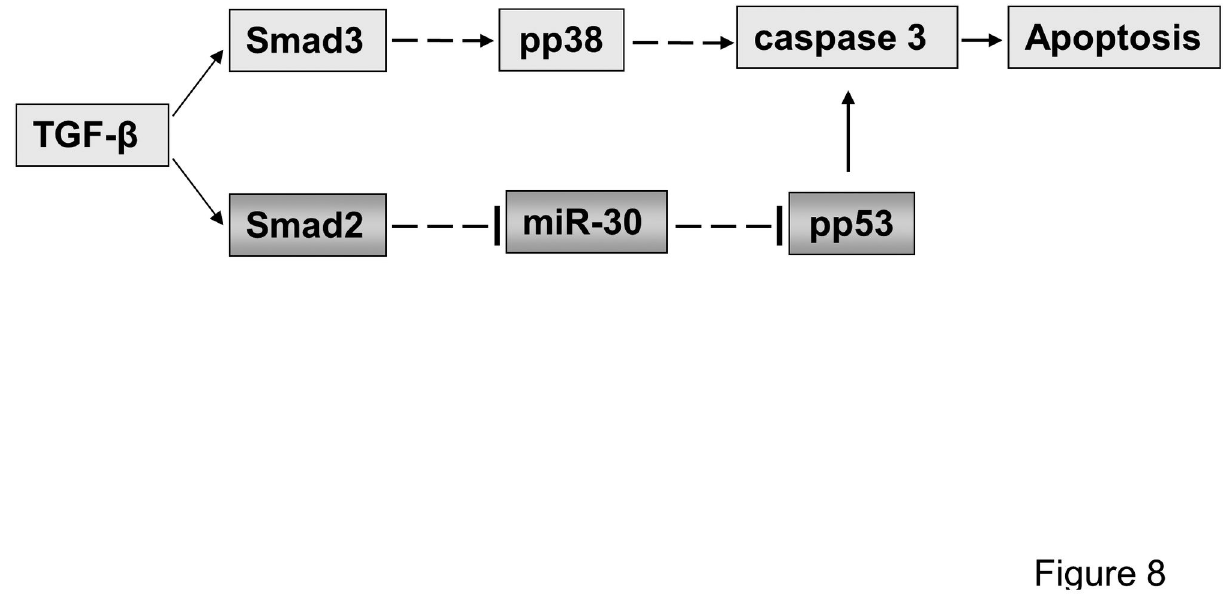
Figure 8. A proposed model of the distinct molecular mechanisms and functional roles of Smad2- and Smad3-dependent pathways in TGF-β-induced pro-apoptotic signaling. Smad3-dependent signaling mediates the activation of pro-apoptotic p38 required for caspase-3 activation and apoptosis [5) [8]. In contrast, Smad2-dependent signaling selectively downregulates miR-30 family transcripts to permit the activation of pro-apoptotic p53, which is required for caspase-3 activation and apoptosis. doi: